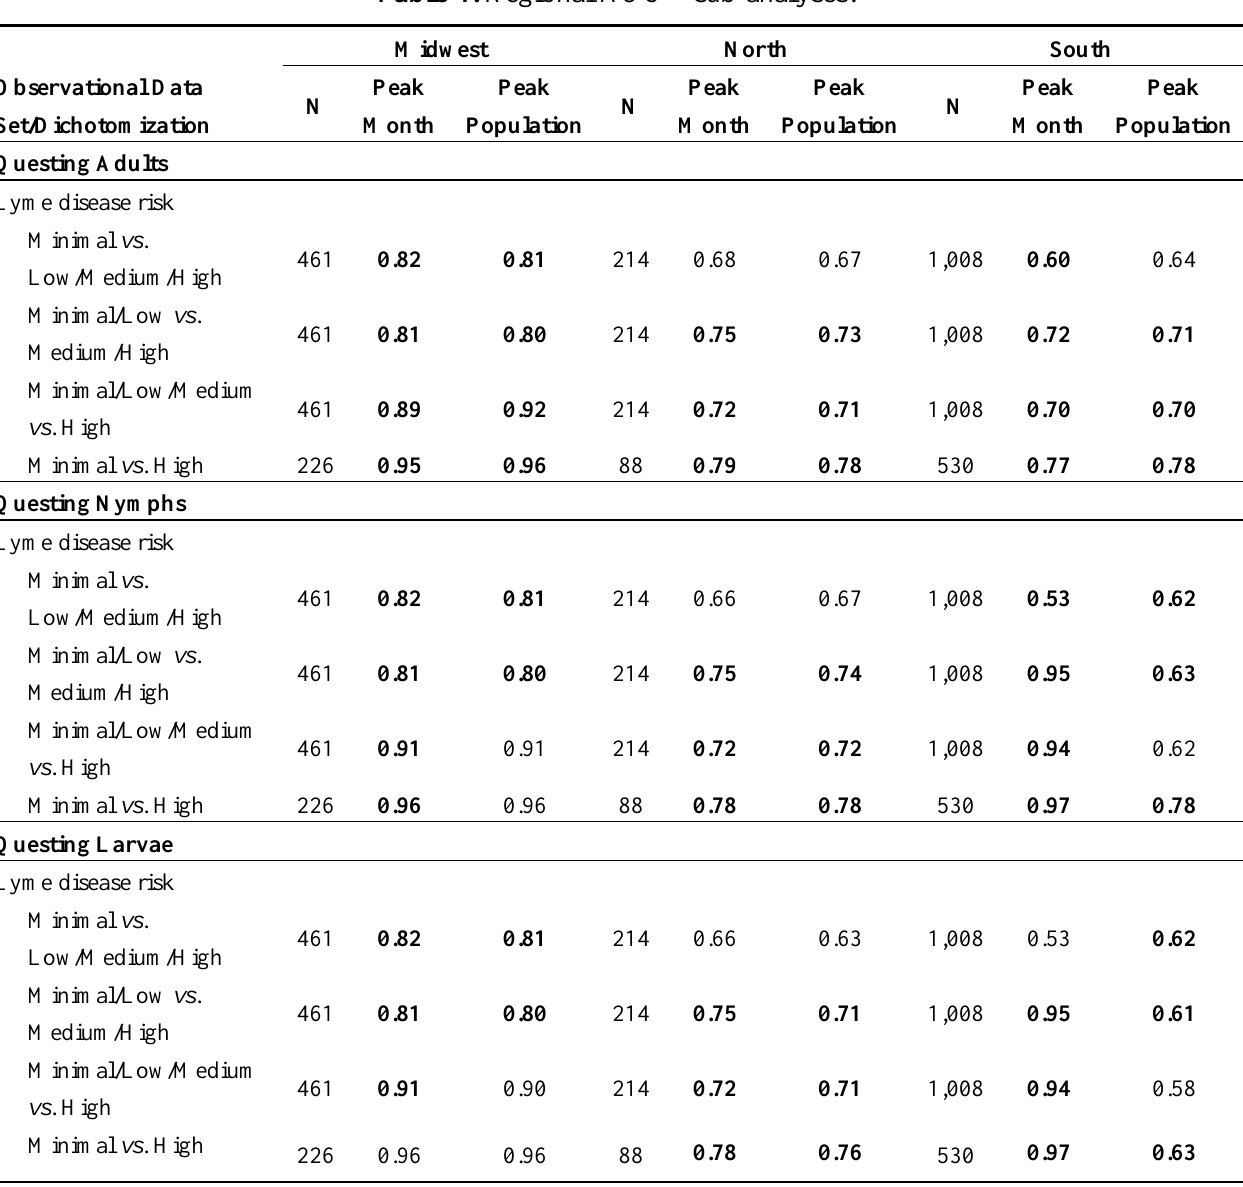
Table 4. Regional AUC *